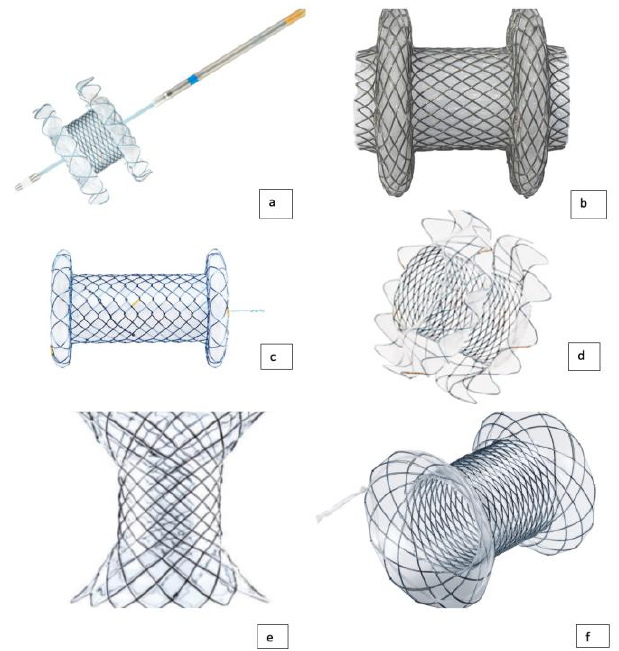
Figure 1. ( a ) Hot-Spaxus stent (TaeWoong Medical); ( b ) Axios stent (Boston Scientific); ( c ) Hanarostent Plumber stent (M.I. Tech); ( d ) Spaxus stent (TaeWoong Medical); ( e ) Aixstent PPS (Leufen Medical); ( f ) Nagi stent (TaeWoong Medical).